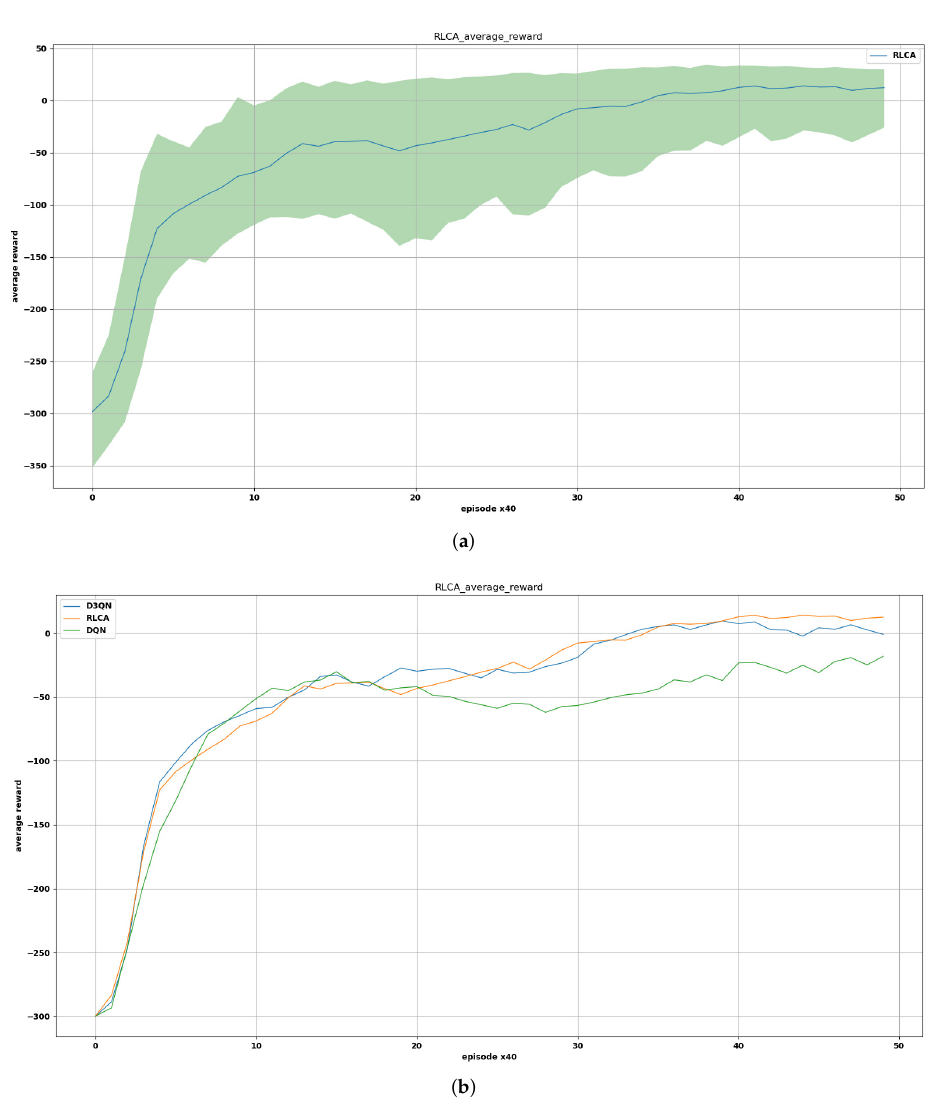
Figure 16. The average reward of the training process. ( a ) The average reward of the RLCA algorithm with the confidence region. ( b ) The average reward of the RLCA algorithm, D3QN algorithm, and DQN